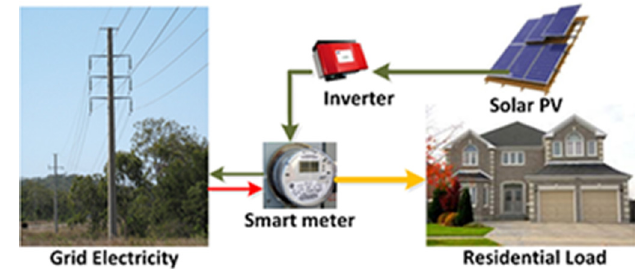
Fig. 4. A typical model in